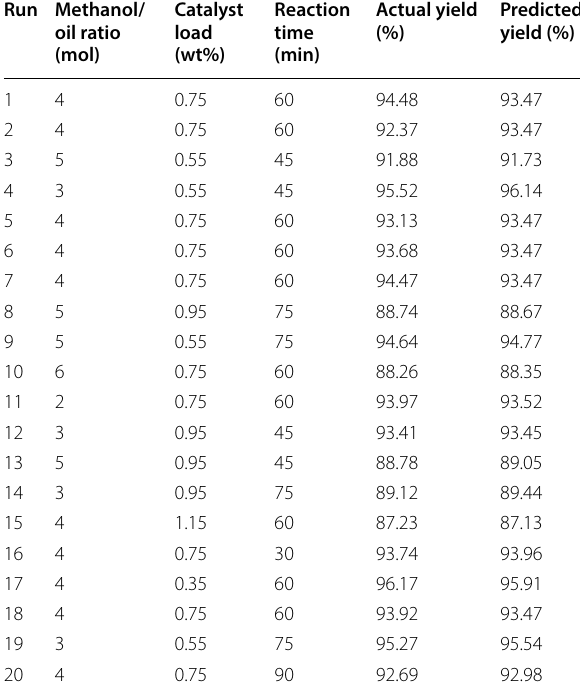
Table 7 Actual vs. predicted oil yield from